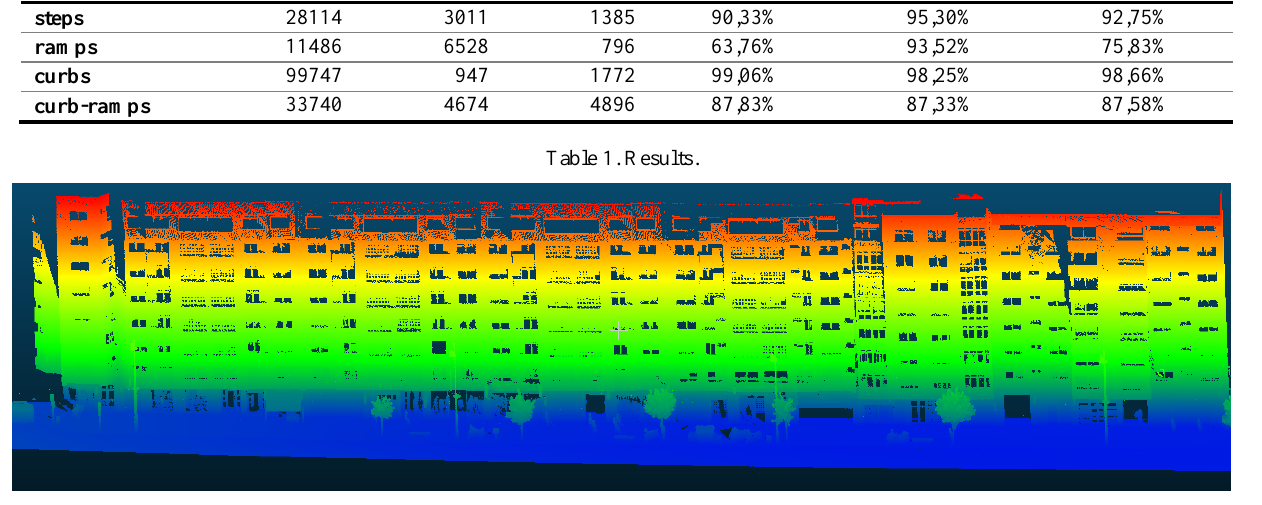
Figure 9. Florida Avenue point